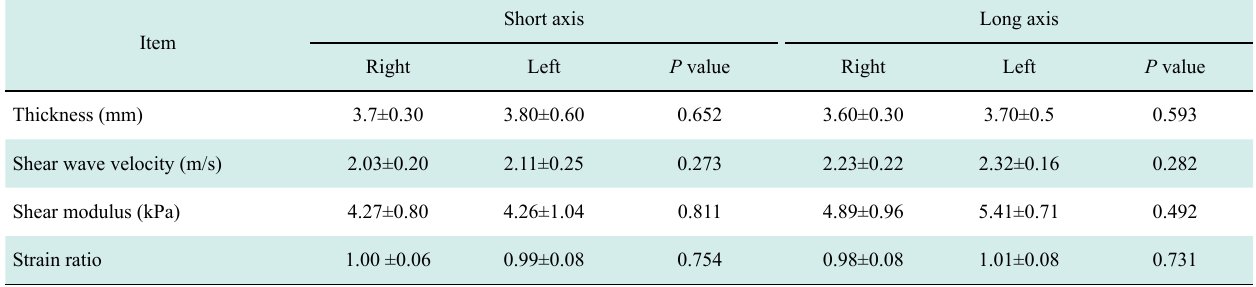
Table 3 Comparison of SCM muscle elastic measurement between short axis and long axis of normal infants Item